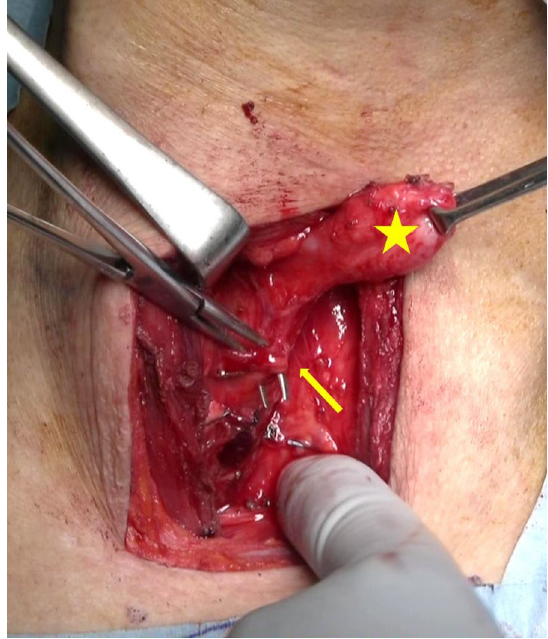
Fig. 5 The case of Zenker diverticulum in our hospital. Intraoperative picture before resection of the diverticulum. The diverticulum (star) arose above the cricopharyngeal muscle